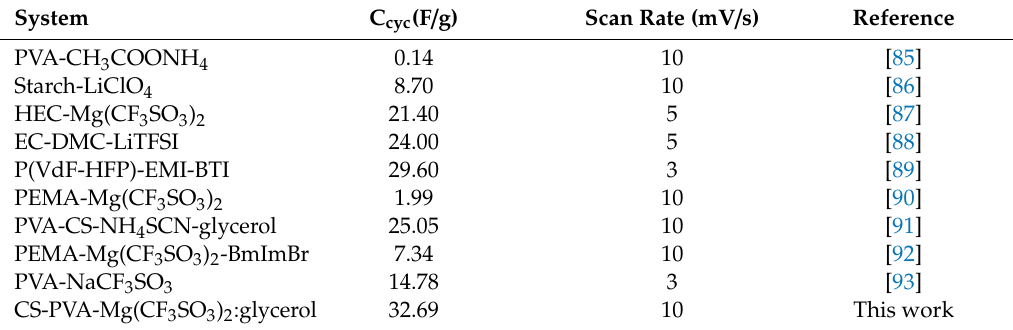
Table 7. Various reported carbon electrode materials based EDLC studies with their respective value of specific capacitance from